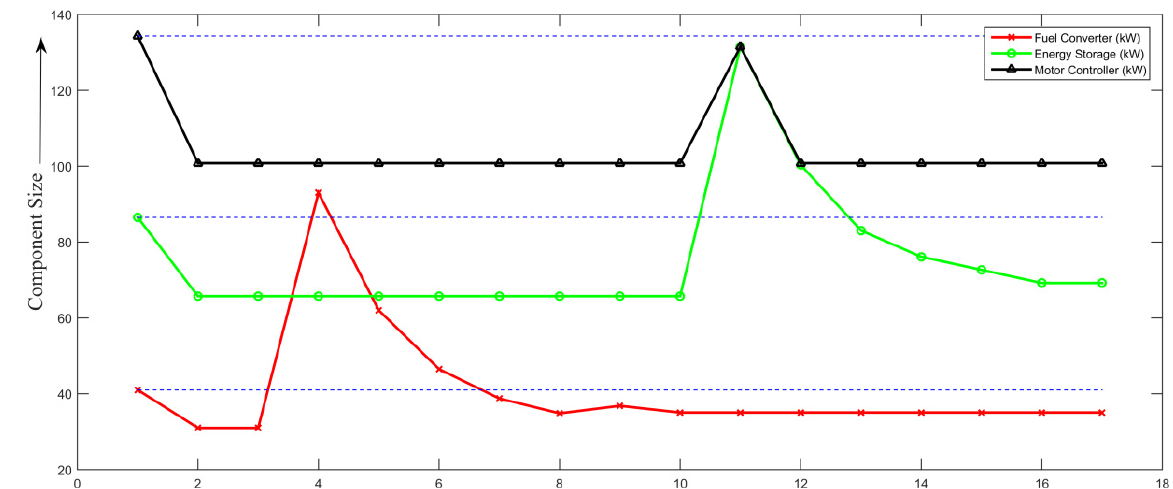
Figure 6. Design iterations.